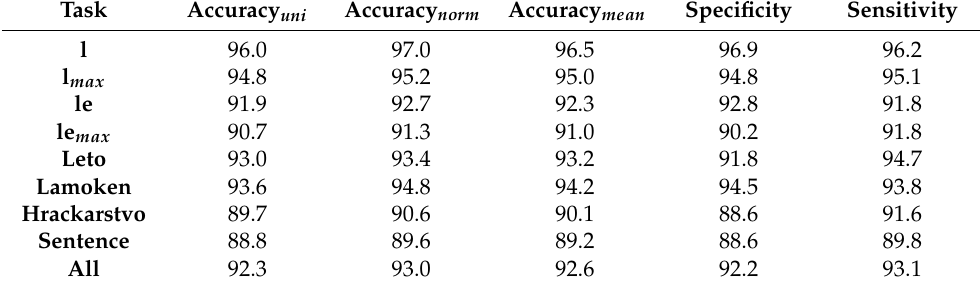
Table 2. Accuracy, specificity, and sensitivity for various tasks.